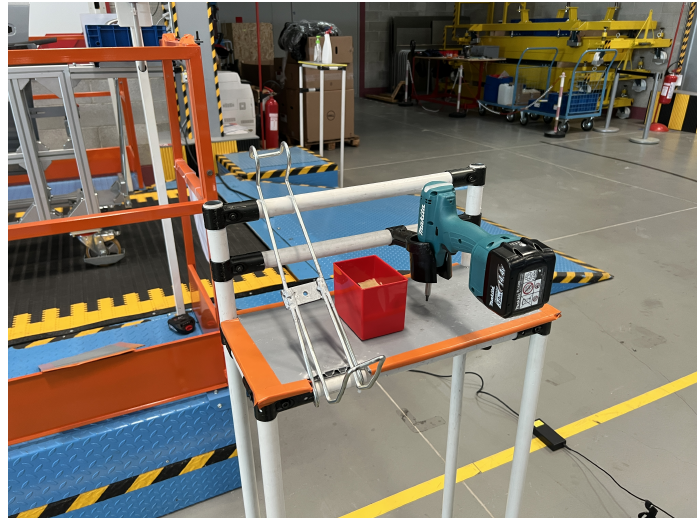
Figure 1. View of the assembly line depicting the screwdriver